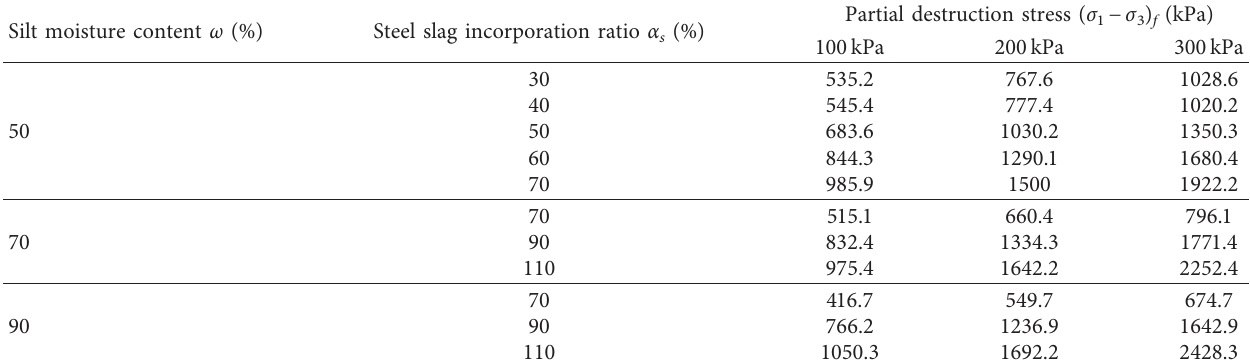
Figure 11: Stress and strain curve of the sample under 70% steel slag incorporation. Table 5: Failure deviatoric stress of steel slag and silt